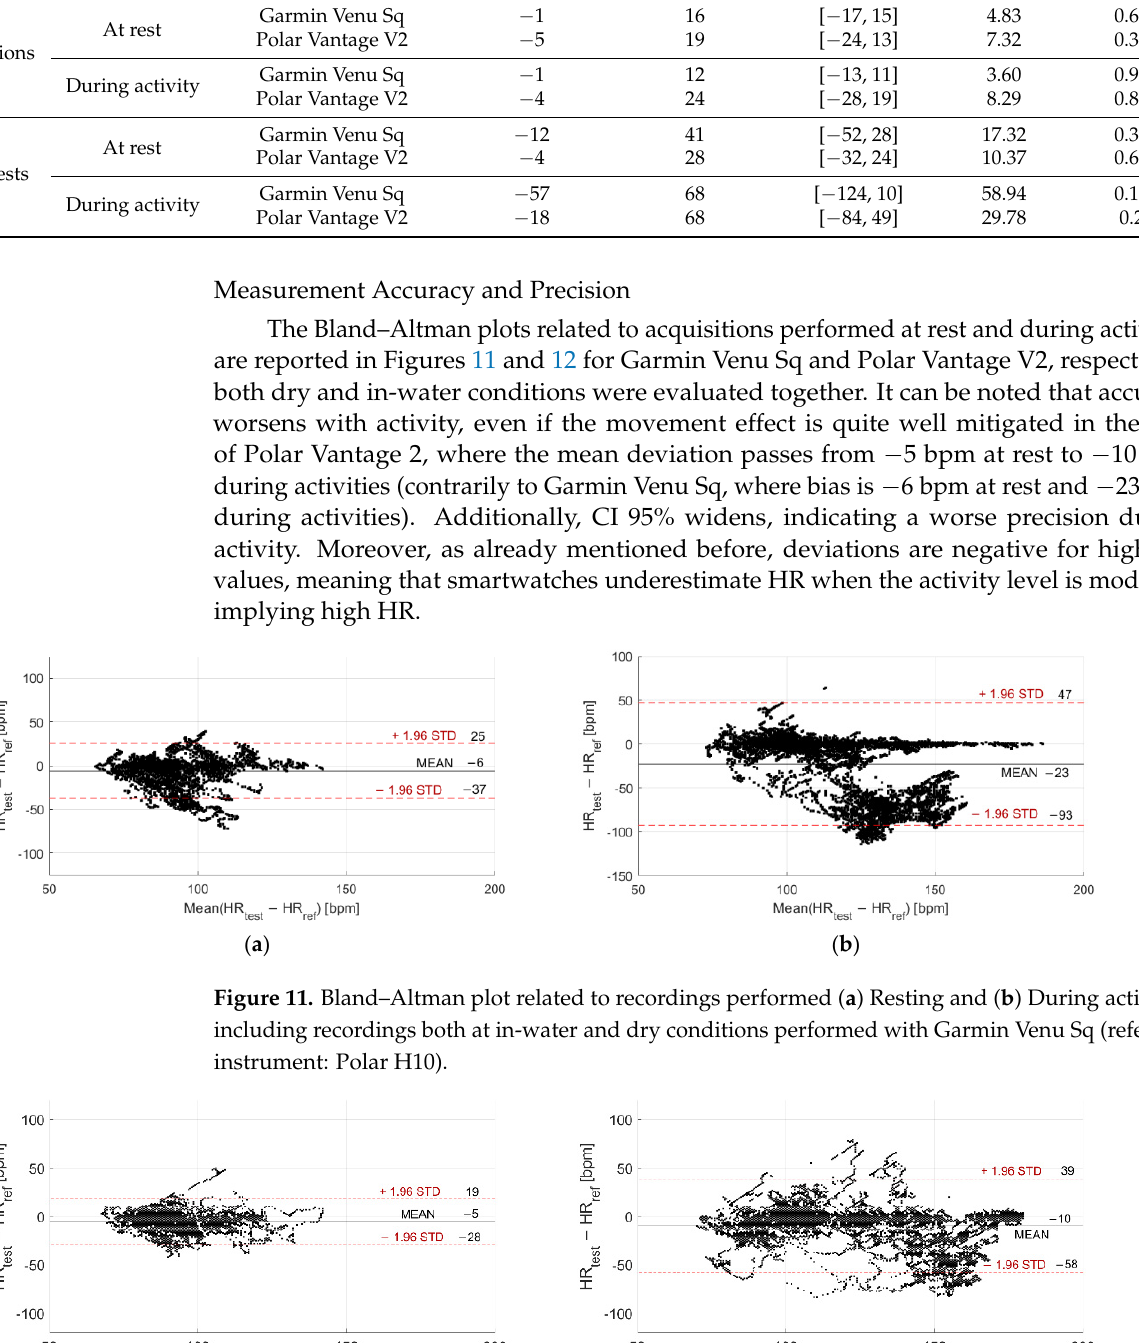
Table 4. Metrological performance of the tested smartwatches in terms of measurement accuracy ( µ ) and precision ( ± 2 σ ), confidence interval at 95% (CI95%), mean absolute percentage error (MAPE), and Pearson’s correlation coefficient ( ρ )—dry vs. in-water conditions, separating tests at rest and during activities.